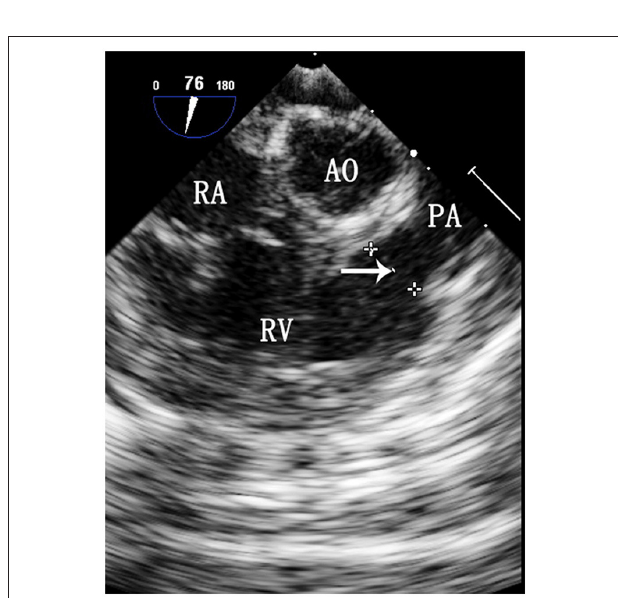
FIGURE 4 | TEE image of the maximum diameter of the pulmonary valve annulus. RA, right atrium; Ao, aorta; RV, right ventricle; PA, pulmonary artery. The arrow indicates the maximum diameter of the pulmonary valve